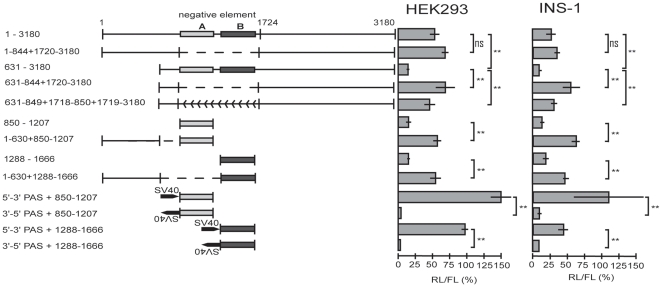
Balancer counteracting the negative elements A and B.The negative elements A and B are indicated by light grey and dark grey boxes, respectively. The deletion of the negative elements is illustrated by a broken line, whereas the inversion of this element is marked by backwards arrows. The insertion of the SV40 termination signal in sense and antisense is marked. The results of luciferase assays were derived and evaluated as in Fig. 2. p-values were determined between two columns as indicated by brackets using an independent-samples t test. Non-significant changes are marked by ns and refer to p-values>0.05 and ** refers to p-values<0.01.